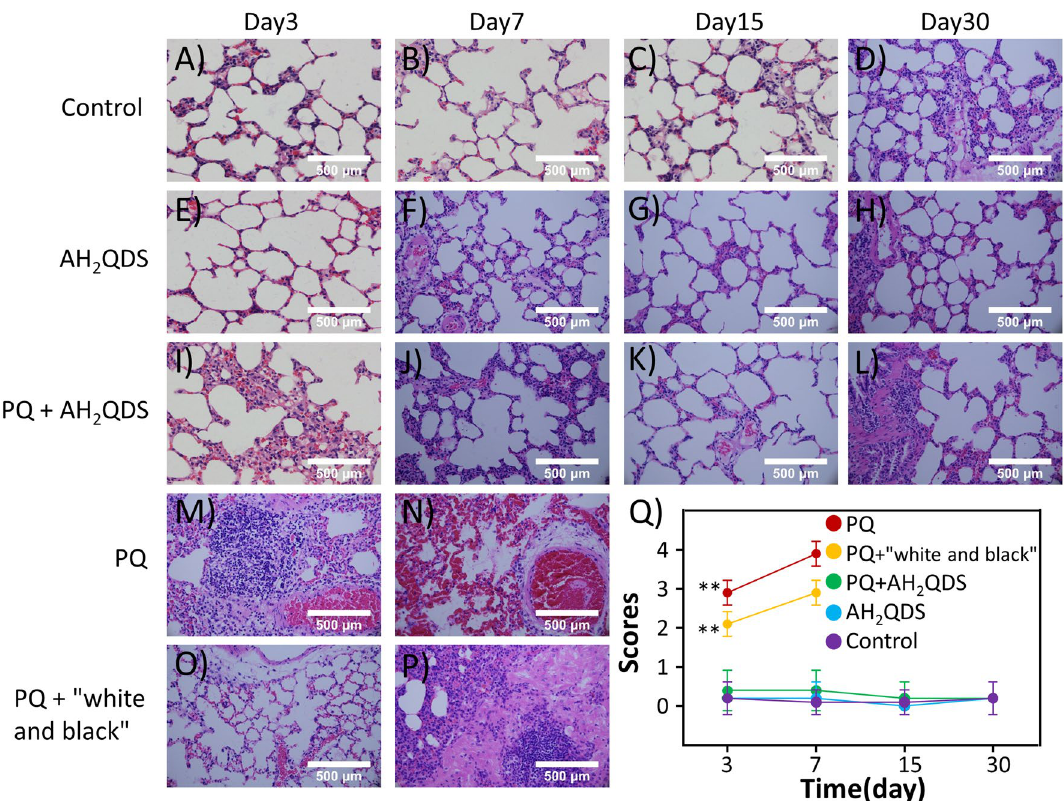
Figure 5. AH 2 QDS decreases lung injury. ( A – P ) H&E staining in lung tissue of rats in the diverse groups at different time points. ( A – D ) The untreated control group. ( E – H ) The AH 2 QDS group. ( I – L ) The PQ + AH 2 QDS group. ( M , N ) The PQ group. ( O , P ) The PQ + "white and black" group. Since a 4X LD50 dose of PQ was used, rats in the PQ group and PQ + "white and black" group died within one week, so there is no data for subsequent time points. ( Q ) Lung injury scores of different treatment groups. Data are presented as means ± SEM, n = 3, *P < 0.05, **P <